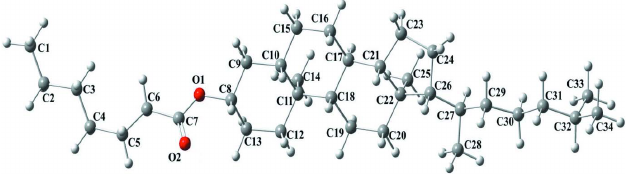
Figure 6 The optimized structure of the title compound, (I).